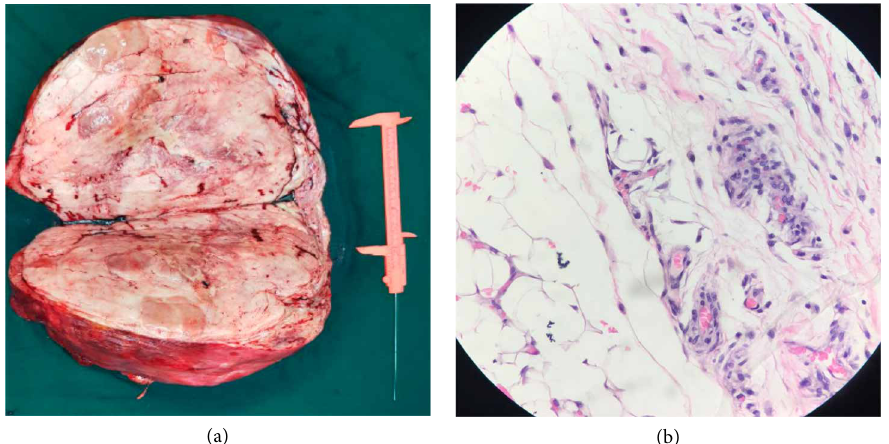
Figure 2: Macroscopic and microscopic view of the tumor. (a) Gross view of the tumor: 47 × 34 × 17 cm and weighs 11 kg. (b) Histopathology showing a well-differentiated liposarcoma with scattered bizarre stromal cells and marked nuclear hyperchromasia (hematoxylin & eosin stain,